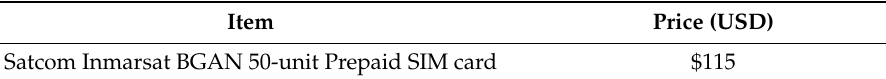
Table 4. The operation cost per 3 months of using a prepaid SIM card.